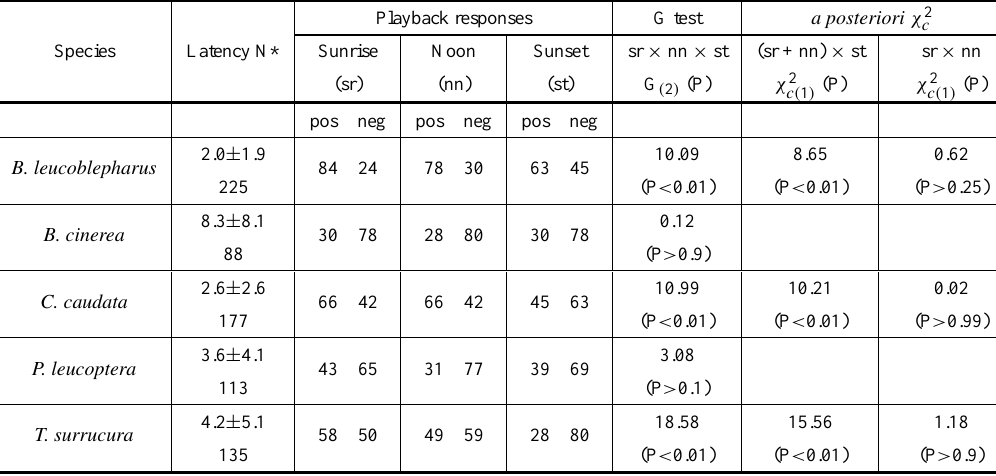
Mean latency values (in minutes) and playback positive (pos) and negative (neg) responses according to the period of the day for the five studied species (N= 108 for each species and period) inside the Morro Grande Forest Reserve. P: significance